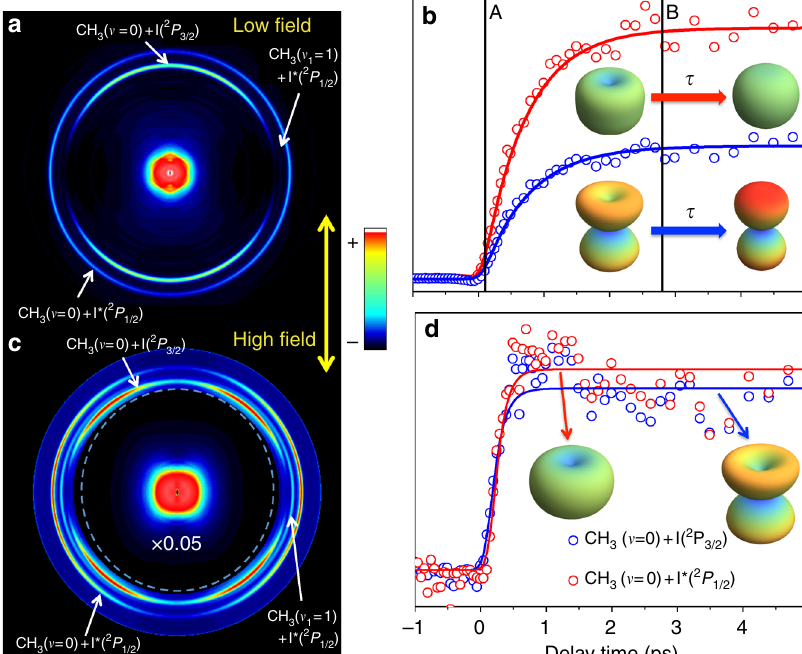
Fig. 3 Angular distributions of methyl fragments under the in fl uence of external NIR fi elds. a Abel-inverted image of the methyl fragment resulting from CH 3 I B -band predissociation at asymptotic pump-probe delay and for NIR fi eld intensity of 0.5 TW/cm 2 . b Global intensity pump-probe temporal behaviour of the signal corresponding to the two channels yielding CH 3 ( ν = 0) (direct and pump-dump, see text for details) observed in a . 3D insets are polar plots of the angular distributions of each channel at delays A and B. c Abel-inverted image of the methyl fragment resulting from CH 3 I B -band predissociation at asymptotic pump-probe delay and for NIR fi eld intensity of 2.5 TW/cm 2 . The intensity of the central part has been multiplied by 0.05 for better visual inspection of the channels of interest. d Global intensity pump-probe temporal behaviour of the signal corresponding to the two channels yielding CH 3 ( ν = 0) (direct and pump-dump, see text for details) observed in c . 3D insets are polar plots of the angular distributions of each channel at the delay indicated on the Figure. The images in a , c show three rings. The outer and middle rings correspond to vibrationless CH 3 ( ν = 0) and symmetric stretch mode excited CH 3 ( ν 1 = 1), respectively, both in correlation with I*( 2 P 1/2 ) fragments. The inner ring corresponds to the pump-dump channel yielding CH 3 ( ν = 0) and ground spin-orbit state I( 2 P 3/2 ). The double arrow shows the direction of the linear polarization of the three laser